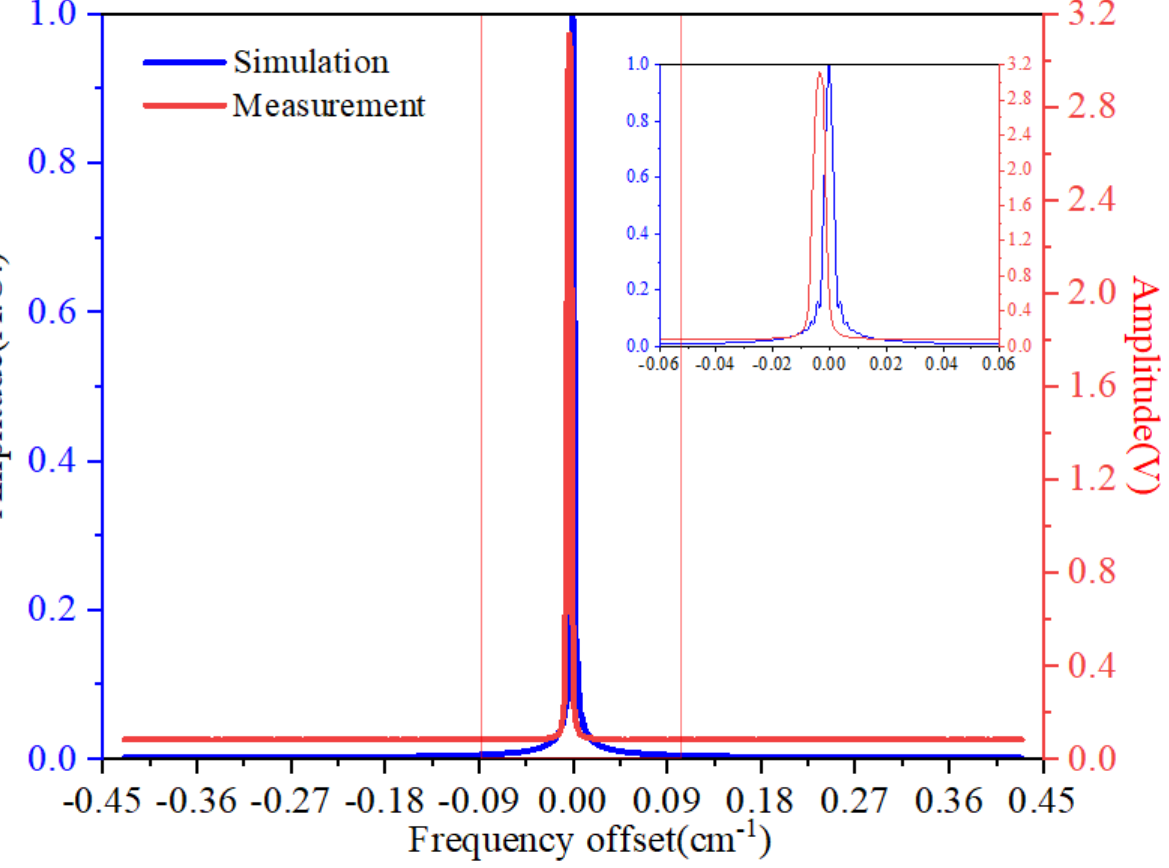
Figure 3. The simulated and measured ILS of 3.53 µ m LHR. The wavelength of local oscillator accuracy and repetition are important parameters of the LHR, the measurement of laser wavelength and the distribution are shown in Figure 4. The maximum and minimum of wavenumber is 2831.9518 cm − 1 and 2831.9497 cm − 1 , the uncertainty is 0.0021 cm − 1 which is little than spectral resolution, and the statistical characterization fits the gaussian distribution, the stability meets the demands of column density measurements.